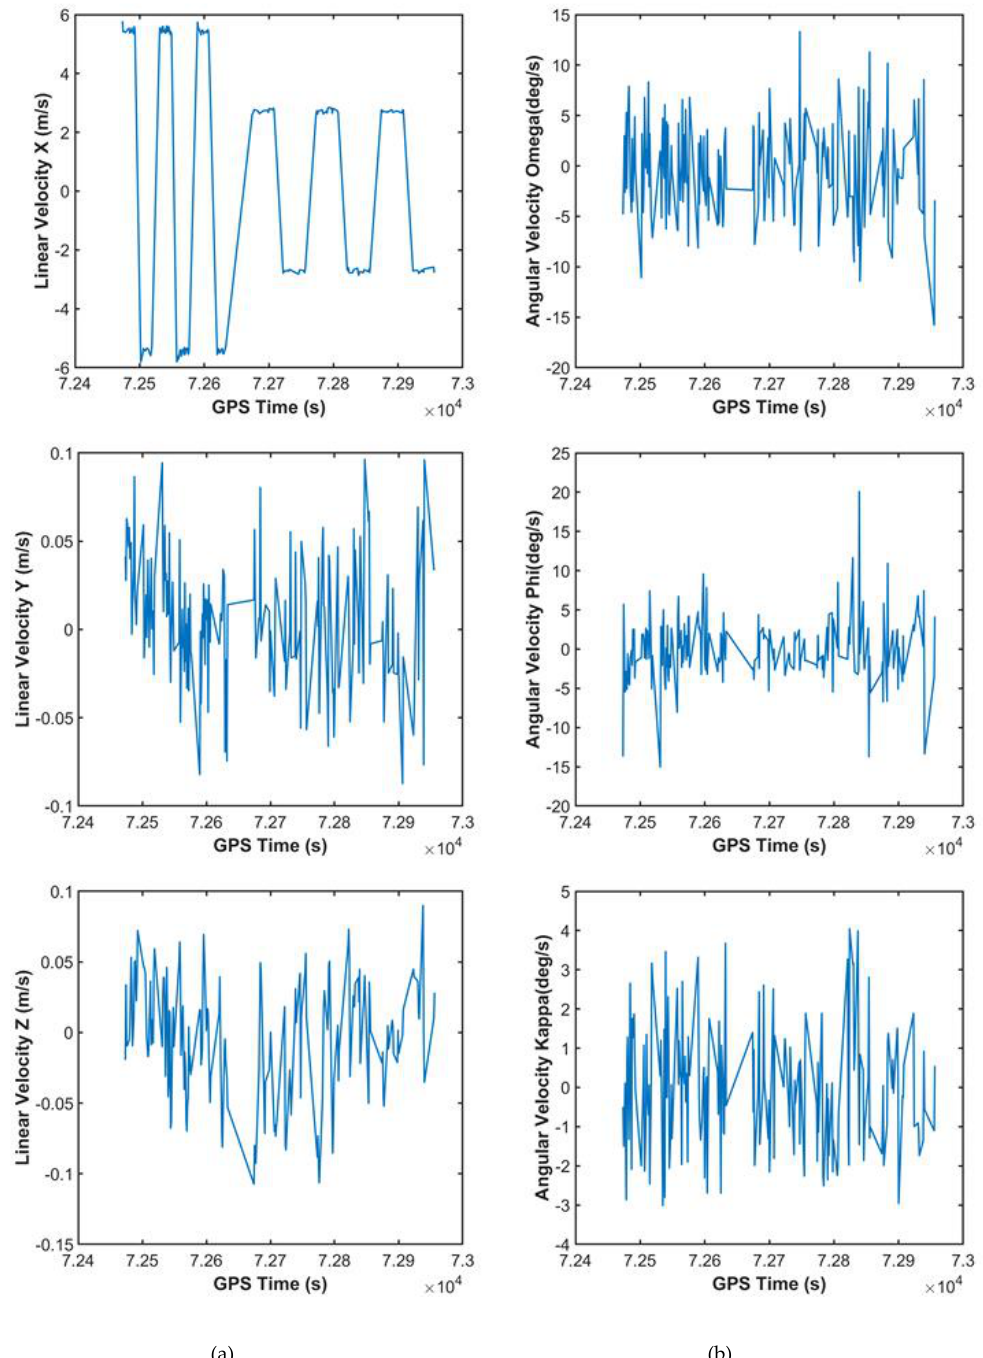
Figure 11. ( a ) XYZ component linear velocity over flight time for the July 25th thermal dataset. ( b ) ω , ϕ , κ component angular velocity over flight time for the July 25th thermal dataset. Five checkerboard targets, used as check points, were deployed in the calibration field for the FLIR and Sony cameras. The ground coordinates of all the checkerboard targets were surveyed by a